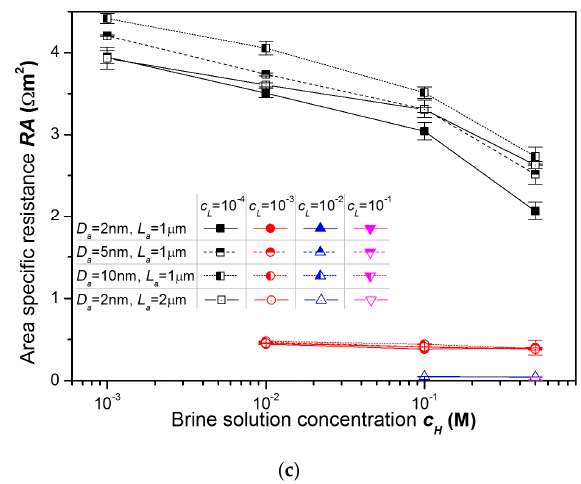
Figure 10. A comparison of: ( a ) power densities, ( b ) diffusion potentials, and ( c ) area specific resistances of the anisotropic nanoporous anodic aluminum oxide membranes with two different lengths and three different pore diameters of the active layer for various combinations of concentrations.